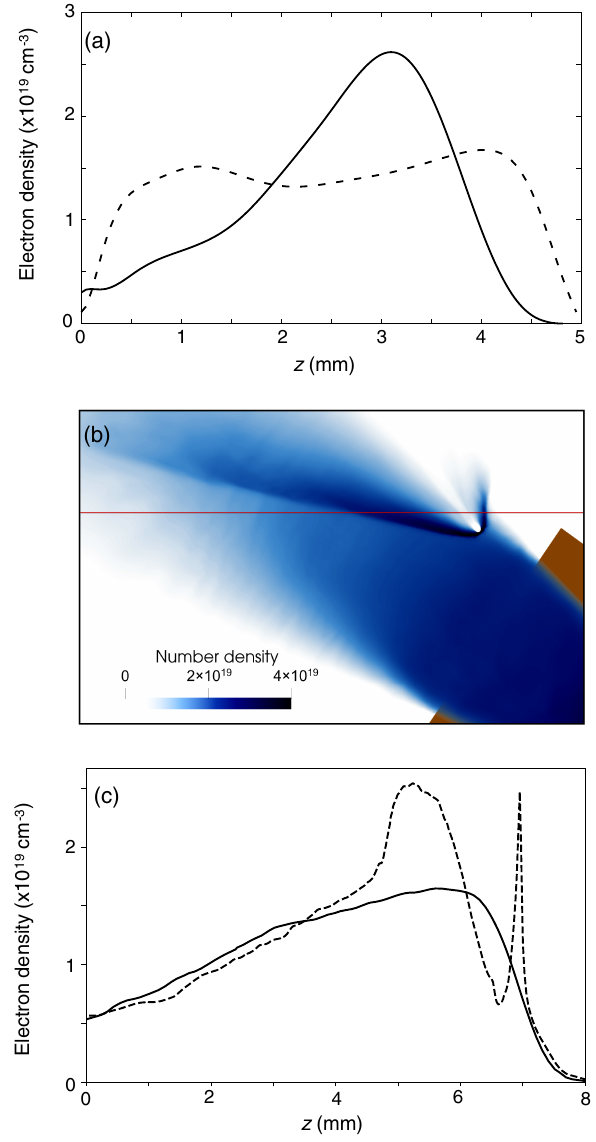
FIG. 2. Measurements and simulations of the density profiles used to improve the efficiency of the betatron source. (a) Measured density profiles of the gas used for the reference case (dotted line) and the longitudinal gradient (solid line). The beveled and tilted gas jets were used to produce the longitudinal gradient. (b),(c) O pen F oam simulation of the transverse gradient obtained by placing a 100 μ m wire on top of the nozzle. Density profile along the laser propagation (red line) without (solid line) and with (dotted line) the